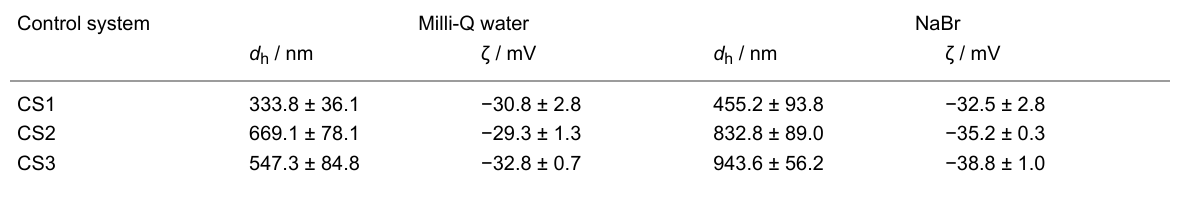
Table 1: The d h and and zeta potential ( ζ ) of the bare TNWs in Milli-Q water and 1 × 10 − 3 mol dm − 3 NaBr after 24 h. γ /g dm − 3 = 1 × 10 − 2 (CS1), 5 × 10 − 2 (CS2), 1 × 10 − 1 (CS3). θ = 25 °C. Control system